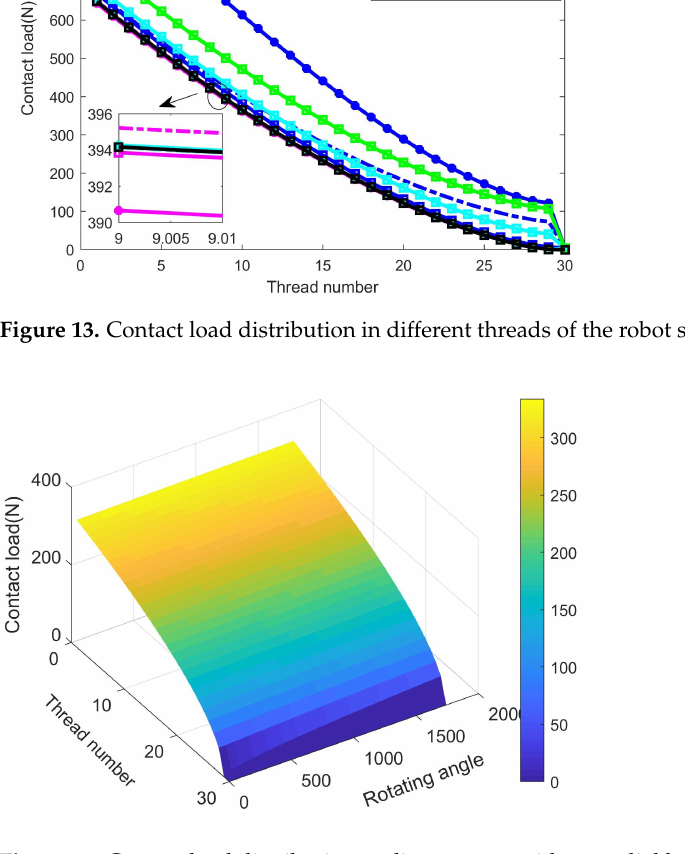
Figure 14. Contact load distribution cycling process without radial load of case